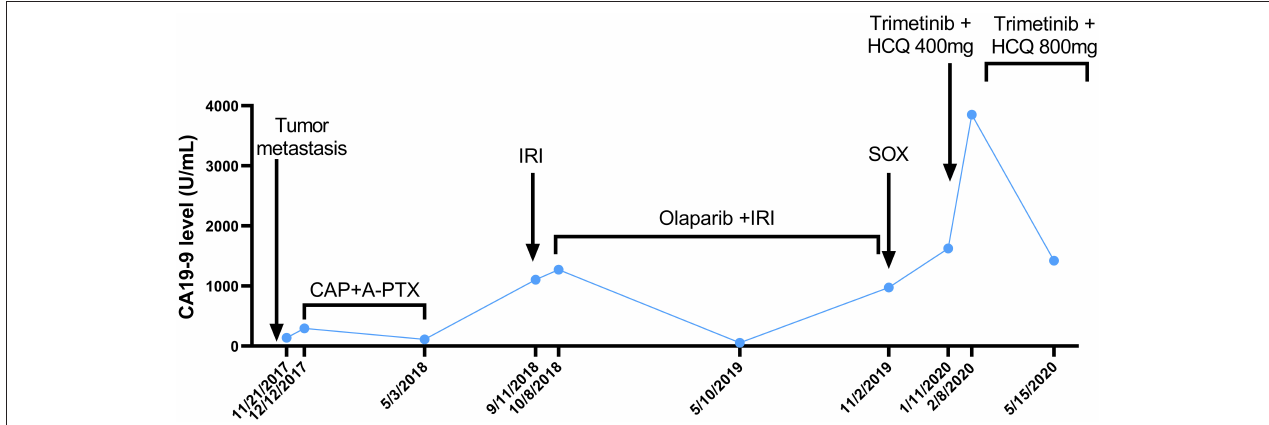
FIGURE 1 | The curve of CA199 change after tumor metastasis. The patient’s CA19-9 level was measured periodically and is annotated with the dates and treatments administered. A-PTX, albumin paclitaxel; CA19-9, carbohydrate antigen 19-9; CAP, capecitabine; HCQ, hydroxychloroquine; IRI, irinotecan; SOX, S-1 plus oxaliplatin.